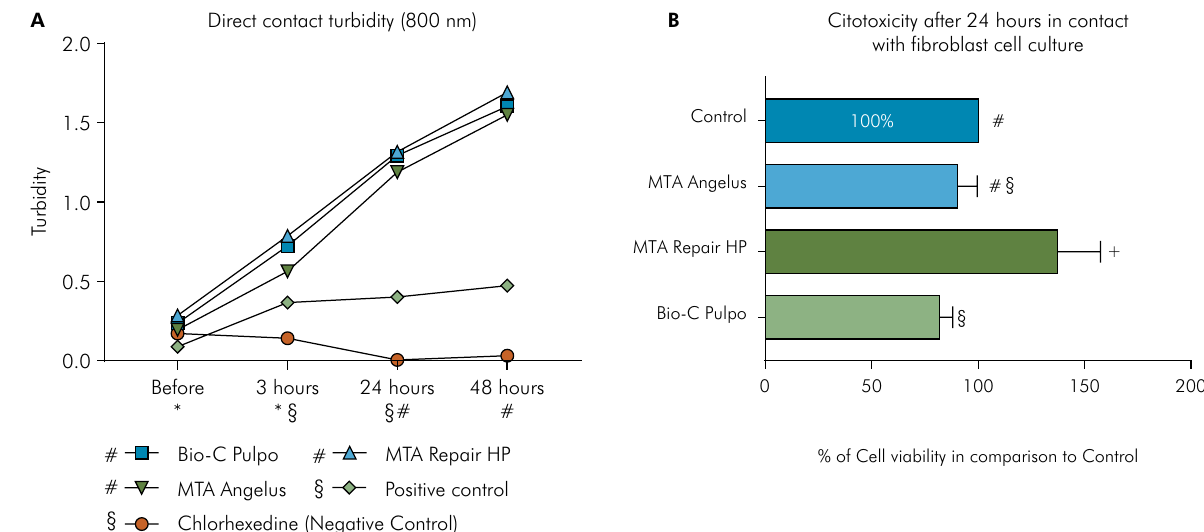
Figure 3. (a) Turbidity in contact with planktonic E. faecalis after 48 hours, for all tested materials. After 48 hours, negative control significantly reduced medium turbidity in comparison with the tested materials, and showed lower turbidity values in comparison with the positive control. (b) Cytotoxicity box-plot in comparison with the control (100%). MTA Repair HP showed the highest cytocompatibility in comparison with the control group, and Bio-C Pulpo showed the highest cytotoxicity. (#, *, §, +) Different symbols represent statistical differences among each period evaluated or material